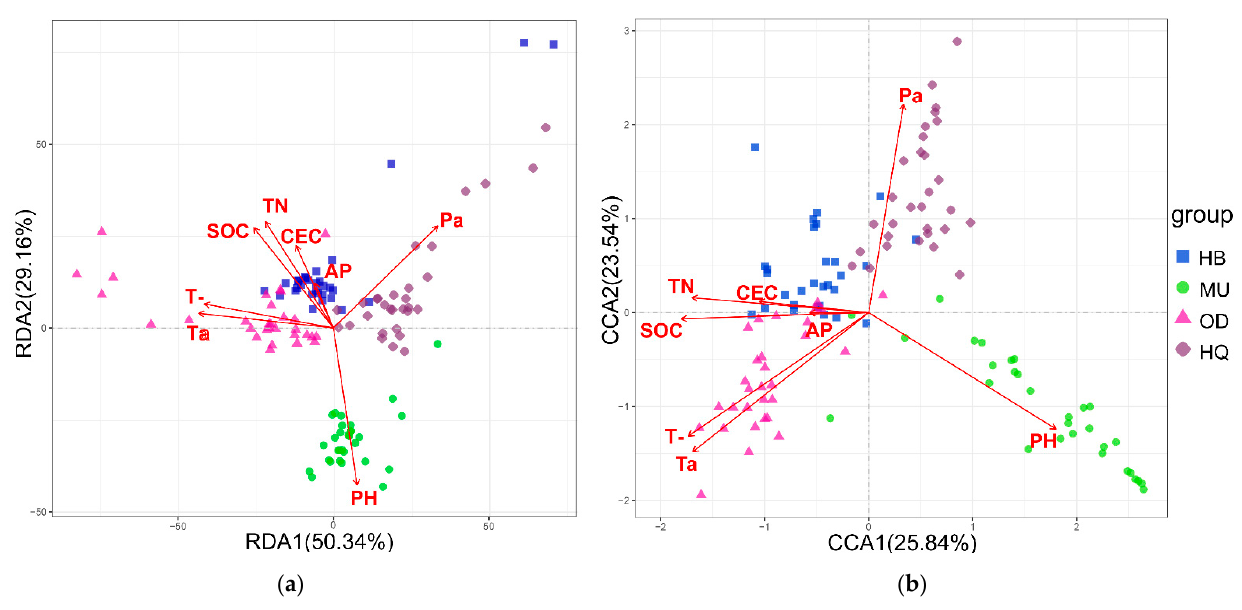
Figure 5. RDA of soil bacterial ( a ) and CCA of fungal ( b ) communities at the genus level and environmental variables.